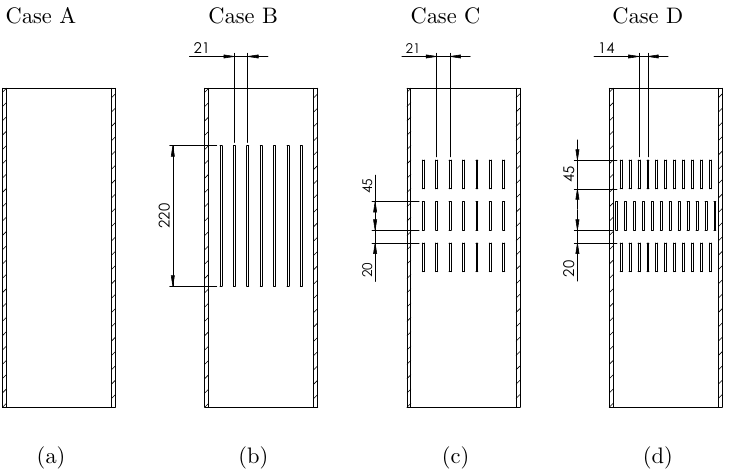
Figure 2. Geometries analysed for the hot side heat-exchanger. ( a ) Flat inner surface; ( b ) Long fins; ( c ) Short aligned fins; and ( d ) Short misaligned fins.